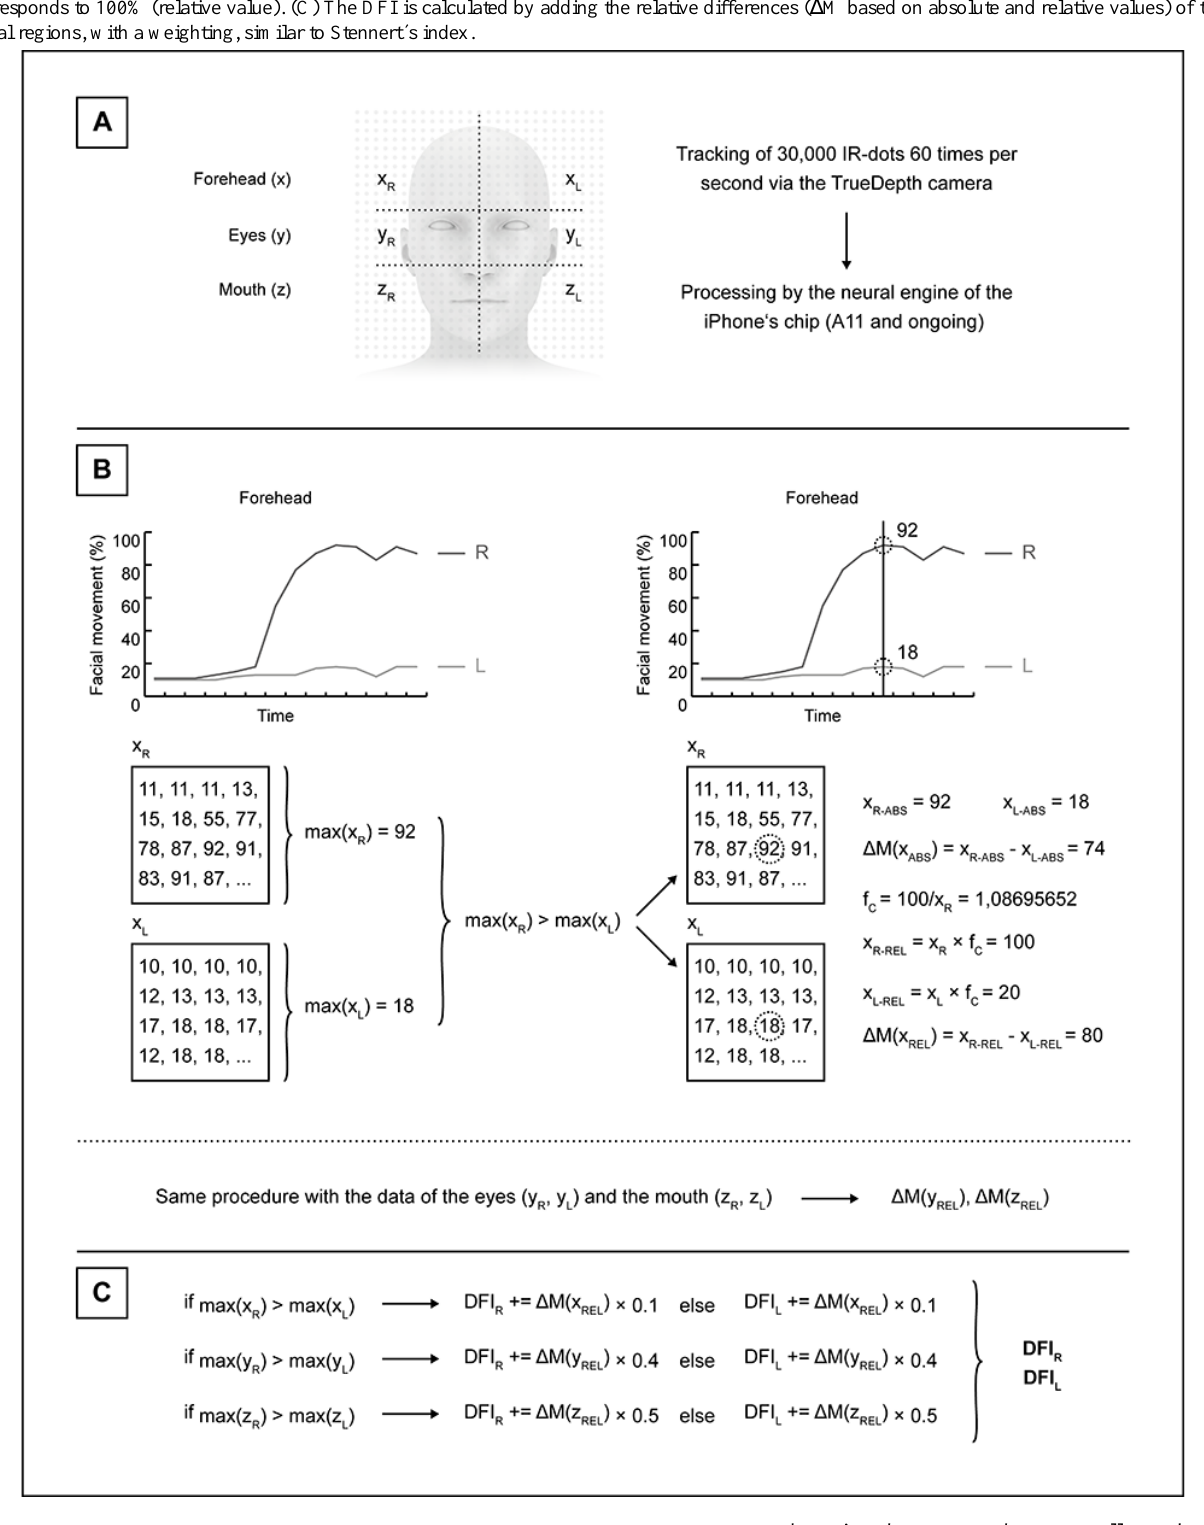
Figure 3. Algorithm for the calculation of the Digital Facial Index (DFI): (A) The TrueDepth camera tracks 30,000 infrared dots projected by the iPhone’s dot projector, and the data are rendered as so-called blend shape coefficients for the (B) measurement time window for the forehead, eyes, and mouth (exemplary data shown), and the maxima of both sides are compared for each facial region; the half of the face with the larger maximum corresponds to 100% (relative value). (C) The DFI is calculated by adding the relative differences ( Δ M based on absolute and relative values) of the 3 facial regions, with a weighting, similar to Stennert´s